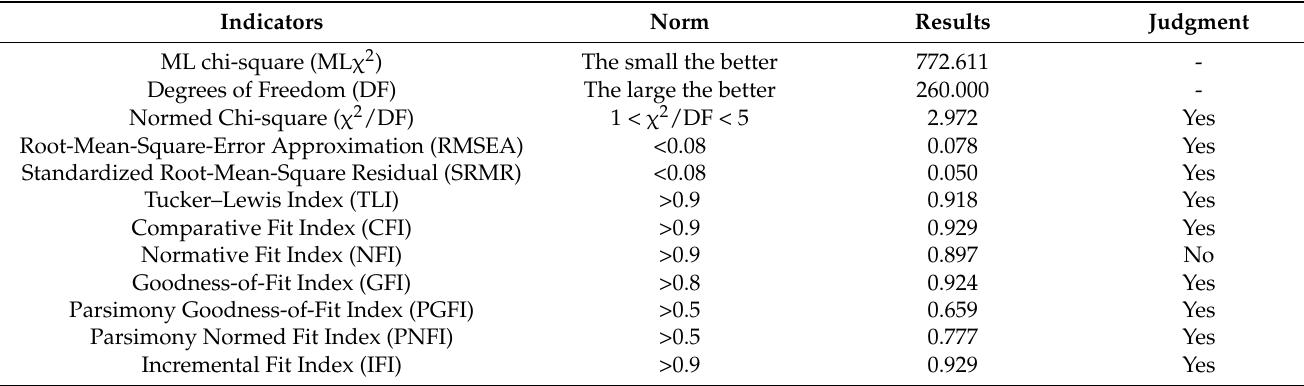
Table 5. Evaluation results.